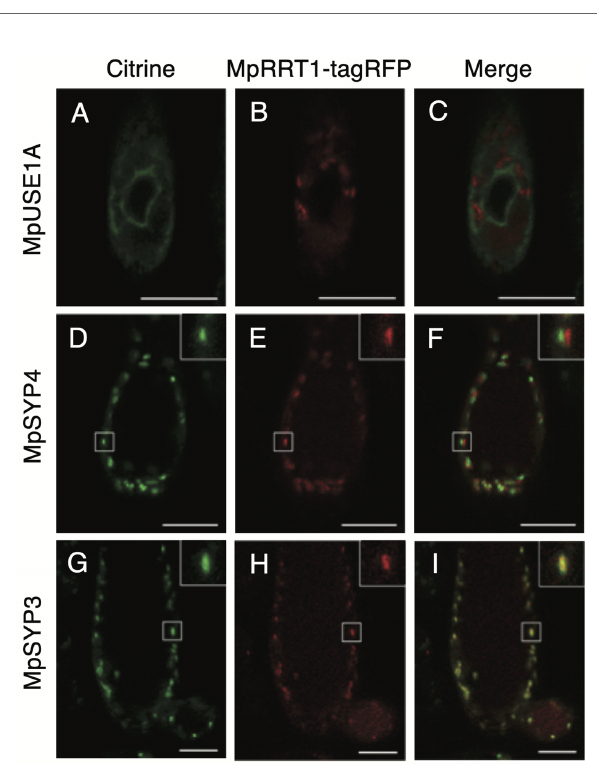
FIGURE 3 | Subcellular localization of MpRRT1-tagRFP protein in liverwort. Thallus cells in 2-week-old gemmalings of transgenic pro35S: Mp RRT1 - tagRFP liverworts co-overexpressing Citrine-MpUSE1A (A – C) , Citrine- MpSYP4 (D – F) , or Citrine-MpSYP3 (G – I) were observed with a laser scanning confocal microscope. The localization of the Citrine-proteins (green) (A, D, G) , tagRFP fl orescence (B, E, H) , and their merged images (C, F, I) are shown. In D – I, small white squares are shown at an increased magni fi cation at the upper right. Scale bars, 25 m